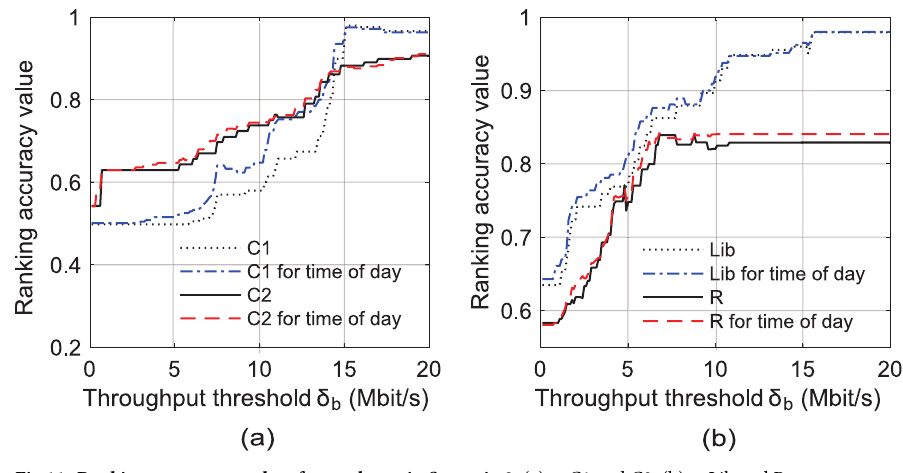
Fig 11. Ranking accuracy results of our scheme in Scenario 2. (a) at C1 and C2, (b) at Lib and R.